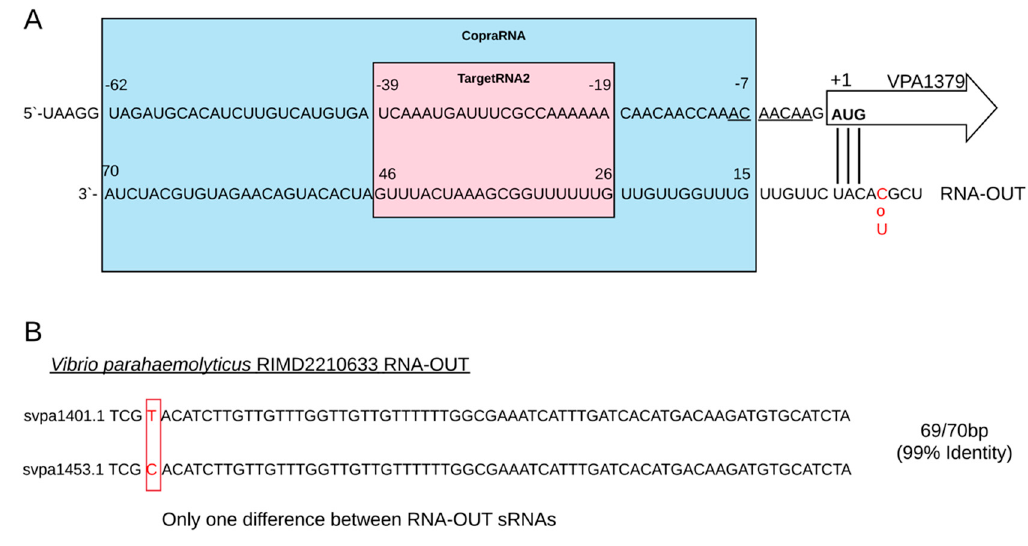
Figure 4. Complementarity of RNA-OUT sRNA and 5 ′ -TIR of transposase VPA1379 mRNA of V. parahaemolyticus reference strain RIMD2210633. ( A ) Sequences of RNA-OUT and VPA mRNA shown as linear structures (red characters indicate the difference between both RNA-OUT). Consensus sequence of Hfq binding 5 ′ -AACAACAA-3 ′ in mRNA is underlined. Start codon AUG is marked in bold. ( B ) Sequences of both RNA-OUT, and only one difference between them when sequences are aligned (red characters in red frame) . To review the proposed secondary structures for pairing with or without Hfq, please see Figure 3B in Reference [5].